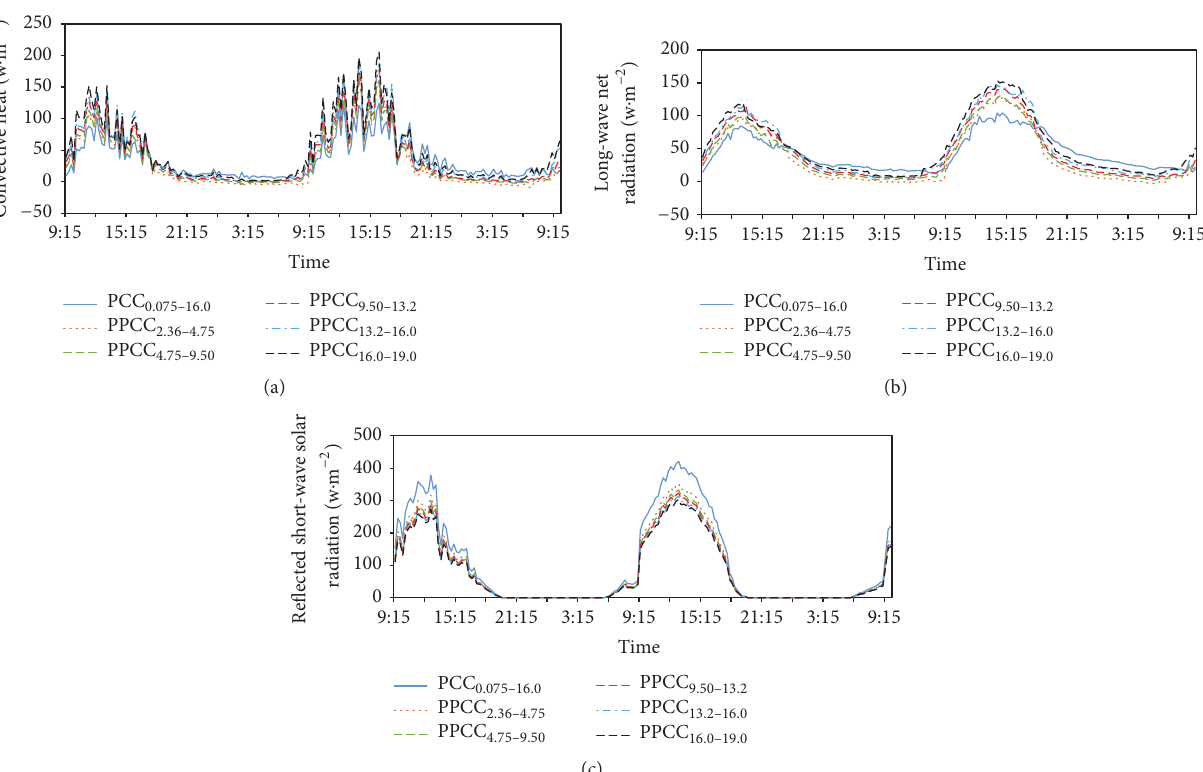
Figure 10: Surface heat flux of different concrete during 48h in June 2016: (a) convective heat; (b) long-wave net radiation; (c) reflected short-wave solar